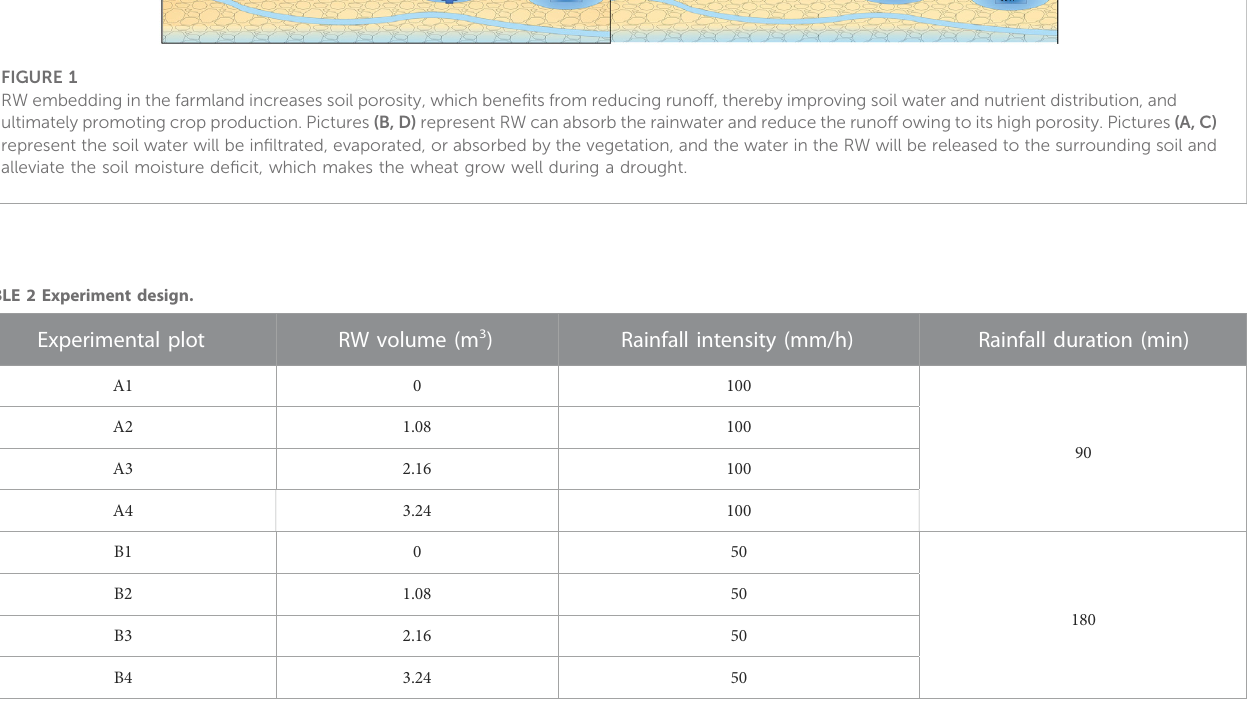
slope of 3 ° (Figure 2). The effective depth of the local soil is 100 mm, so the RW is embedded in a depth of 30 – 70 cm. The devices in every plot includes arti fi cial rainfall devices (Figure 3A): four conical nozzles are evenly distributed over each experimental plot; Wind dodger Figure 3B: polyethylene curtain is installed in the east-west direction of the experimental plots, which aims to reduce the in fl uence of wind; Water-stop sheep Figure 3C: each experimental cell is isolated by a 1 m deep steel plate to mitigate the horizontal soil moisture exchange within the effective depth; Rain trap Figure 3D: it is mainly used to prevent rainfall splash into the experimental plot; Runoff canal Figure 3E: a baf fl e with a certain inclination is laid fl at at the bottom of the slope to make the runoff fl ow to the outlet section; Water tank Figure 3F: we set up the exit section of the experimental plot to collect the runoff; Moisture sensor Figure 3G: FDR sensors are buried at 0.2, 0.4, and 0.6 m in the center of each experimental plot respectively, which is to monitor the variation of soil moisture (Lv et al., 2020; Li J. N. et al., 2022).